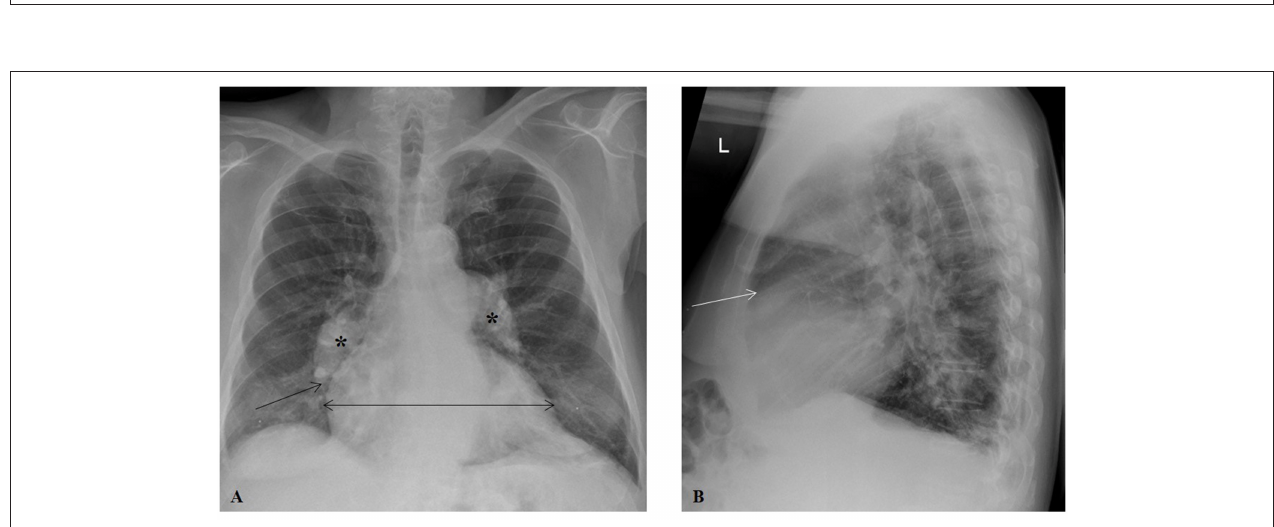
FIGURE 2 | Proposed Step-Wise Approach In Lieu of Traditional “Shotgun” Approach for the evaluation of Pulmonary Hypertension (PH). Since many patients with PH in the developed world have left heart (LH) disease, the echocardiogram is the preferred test for initial cardiac work-up; if findings are consistent with pulmonary venous hypertension (PVH), treatment for left heart disease is recommended first before automatically proceeding to other tests, such as invasive hemodynamic testing. Other signs of LH disease include reduced left ventricular ejection fraction, aortic valve disease, and mitral valve disease. Treatment of LH disease is dependent on the underlying etiology, but in group 2 PH many patients will improve with diuresis and lowering of systemic blood pressure with vasodilators. Further non-invasive imaging or invasive catheterization can be considered as second-line options. MRI can be considered for prognosis and follow-up. ANA, antinuclear antibody, CpcPH, combined pre- and post-capillary pulmonary hypertension; CT, computed tomography; HIV, human immunodeficiency virus; LH, left heart; MRI, magnetic resonance imaging; PAH, pulmonary arterial hypertension; PFTs, pulmonary function tests; V/Q, ventilation/perfusion. Adapted from Freed et al. ( 18).